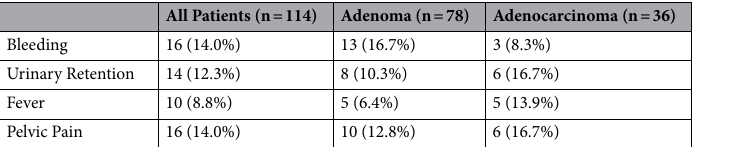
Table 2. Post-operative complications following